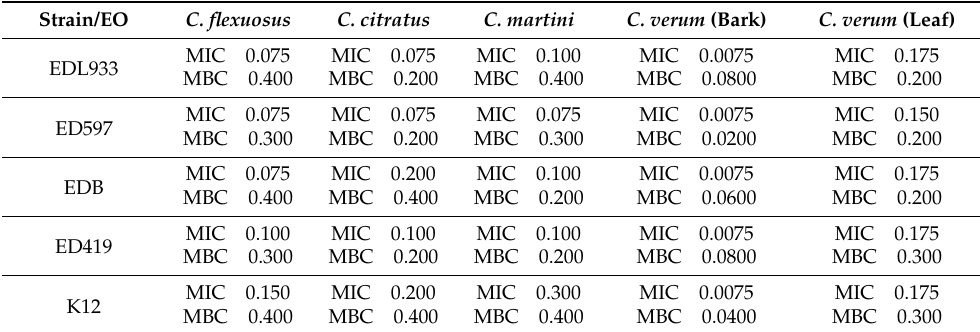
Table 2. Minimum inhibitory and bactericidal concentration of EOs against E. coli strains. The results shown are in percentage ( v / v ) and from three independent